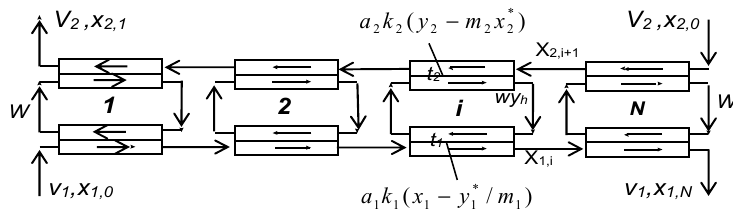
Figure 3. Schematic diagram of multistage three-phase extraction processes.